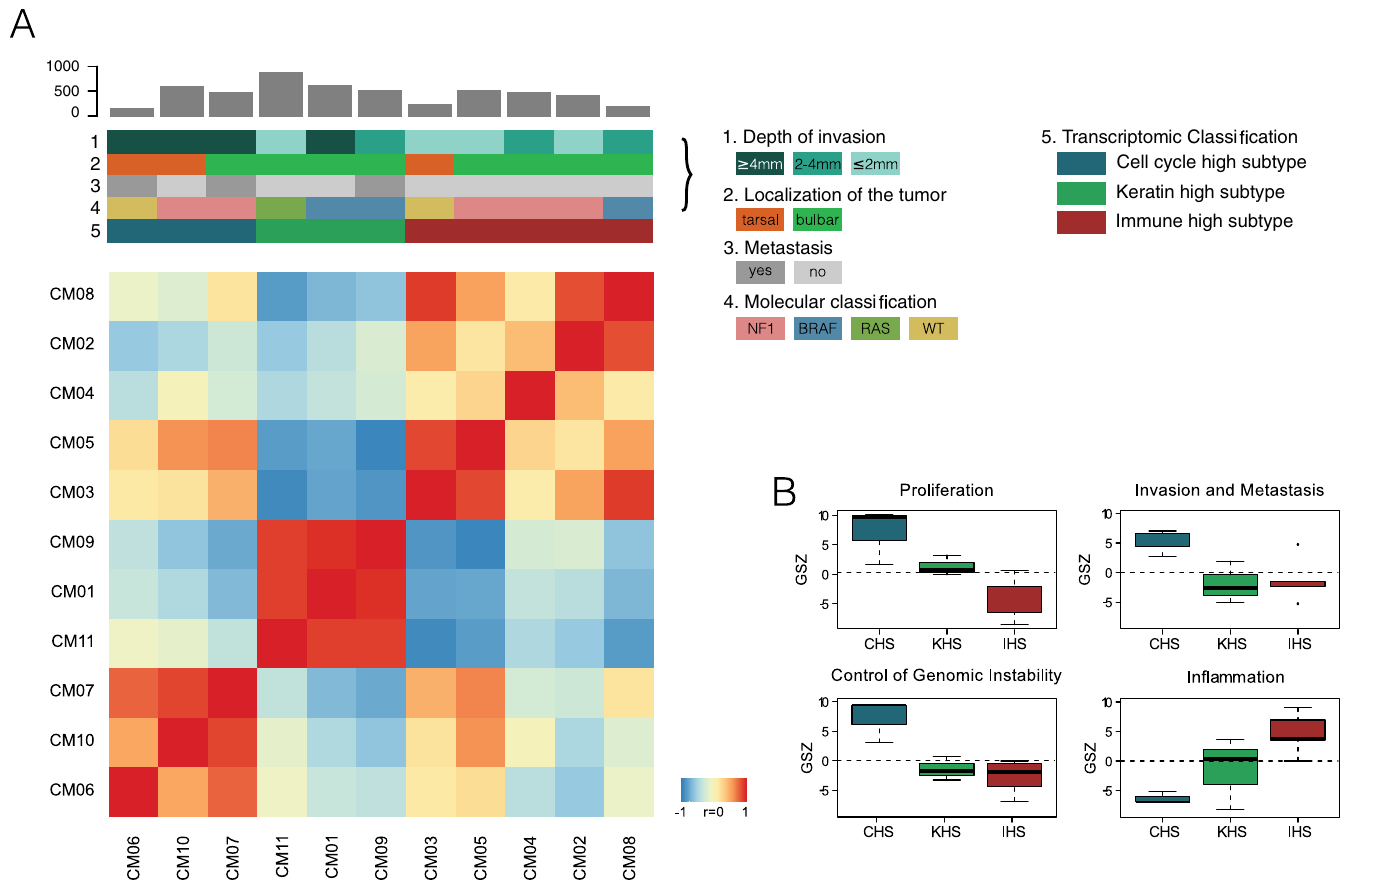
Fig 6. Transcriptomic classification of CJM. (A) Heatmap depicting pairwise similarity (Pearson’s correlation coefficients) between the Self Organizing Maps (SOM) portraits of single patients, highlighting the presence of three distinct clusters of samples, based on gene expression similarity (CM06-10-07, CM11-01-09, and CM03- 05-04-02-08). CM gene sets mapped to the data allow for the classification of CJM into an “cell cycle high subtype”, a “keratin high subtype”, and a “immune high subtype”. Grey bars on the top of each column indicate the number of non-neutral coding somatic variants in each patient. (B) Overexpression profiles in selected hallmarks of cancer gene sets, scaled in units of the gene set Z-score in the three clusters.